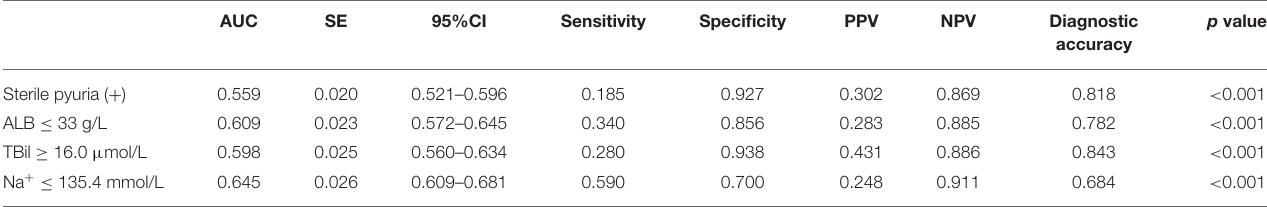
TABLE 5 | The Ability of sterile pyuria, ALB, TBil, and Na + cut-off values in IVIG resistance